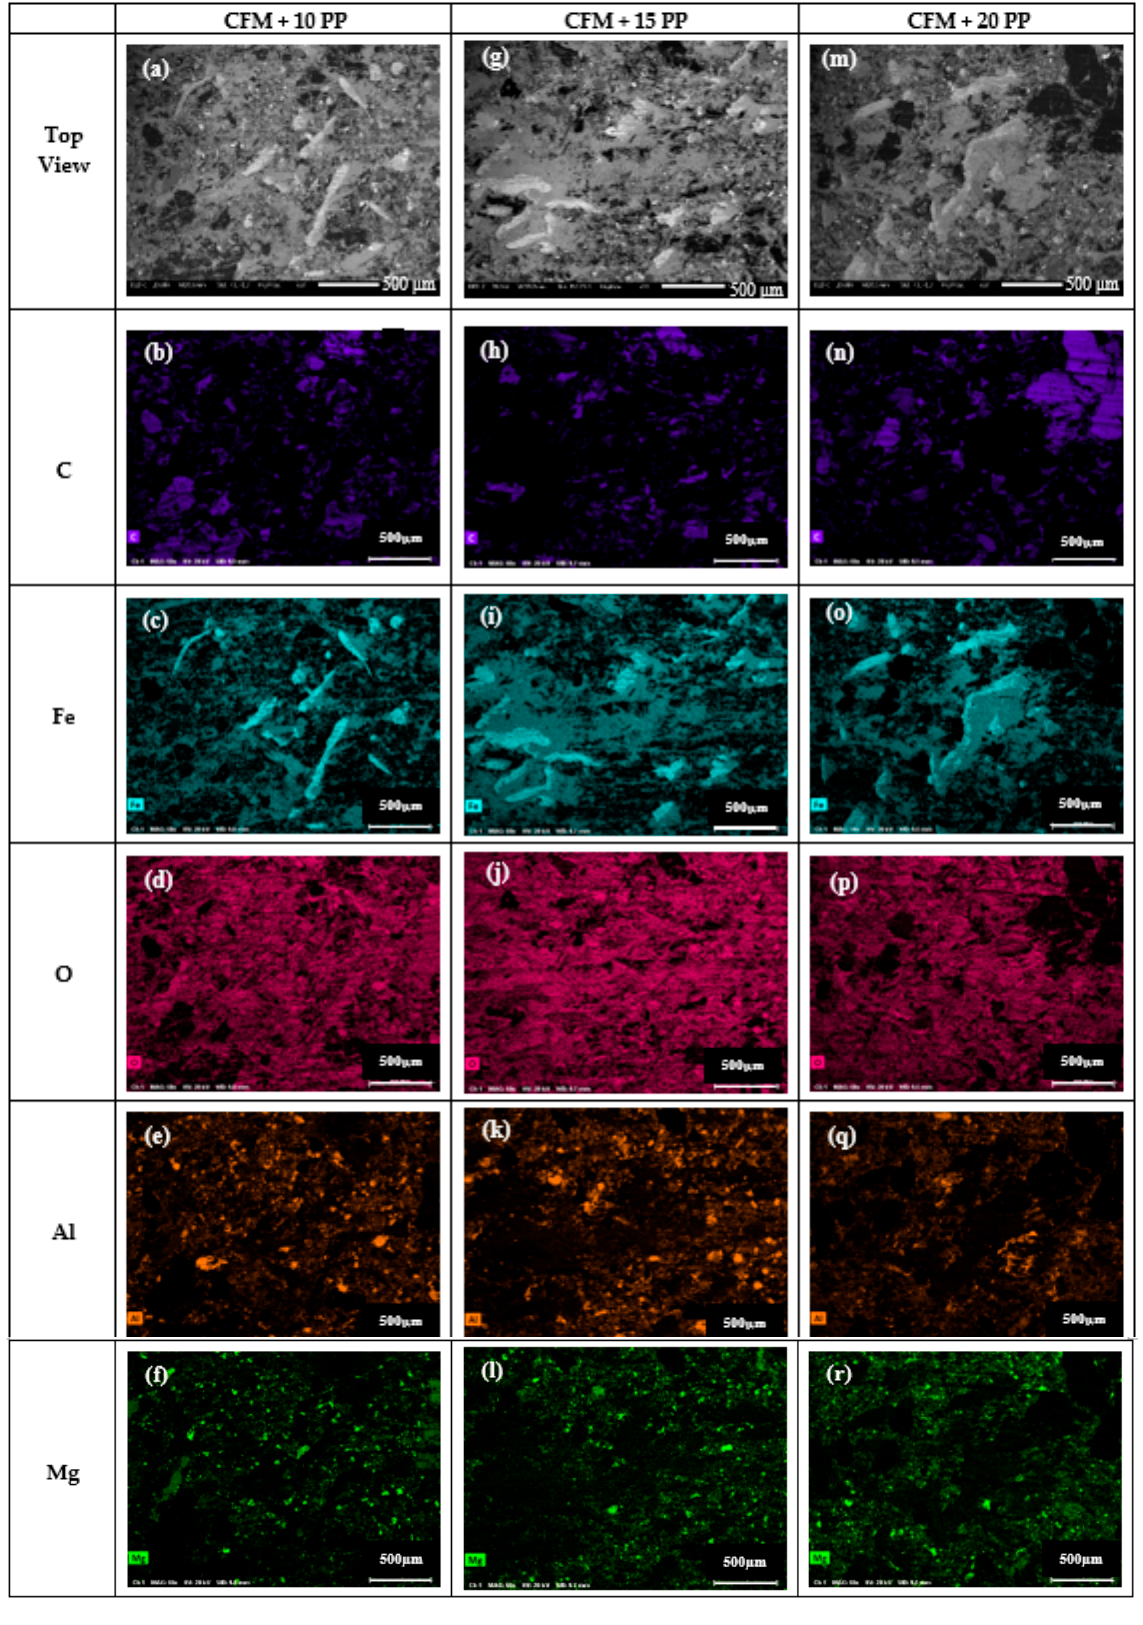
Figure 13. Worn top surfaces of CFM with waste: ( a – f ) 10 PP; ( g – l ) 15 PP; ( m – r ) 20 PP.